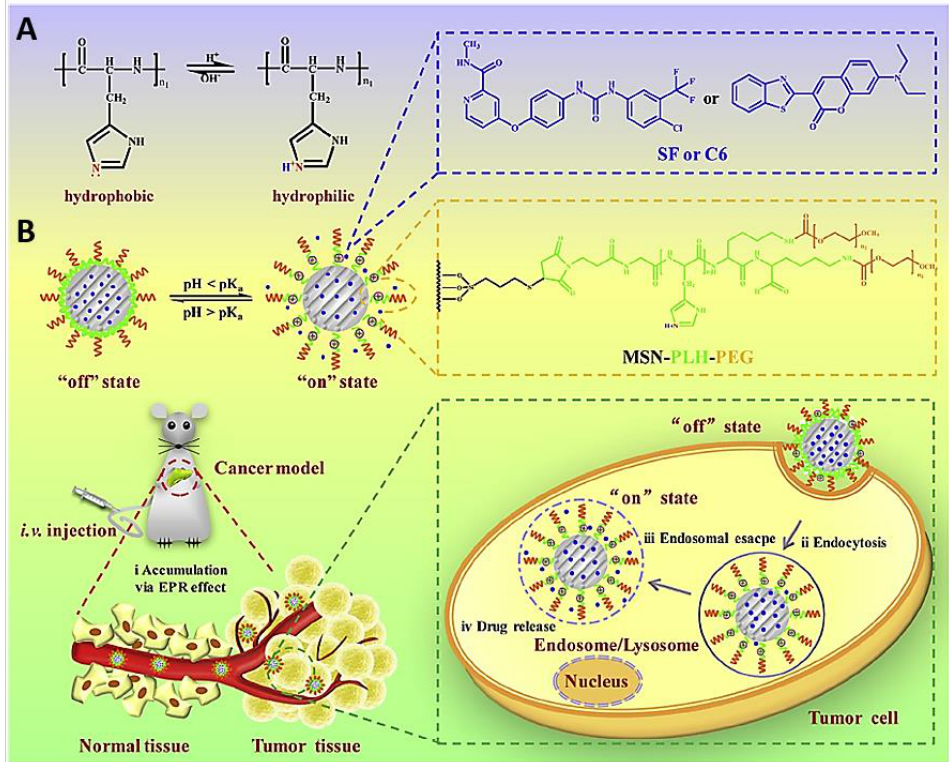
Figure 16. Schematic illustration of: ( A ) The pH-responsive principle of PLH. At neutral pHs, PLH are hydrophobic; whereas at low pH, unsaturated nitrogen in imidazole accepts protons, thereby, PLH displays hydrophilicity. ( B ) Schematic of the pH-controlled drug delivery of SF/MSNs-PLH-PEG bearing an “on-off” switch. (i) Nanoparticles with an “off” switch accumulate in tumor site via EPR effect; (ii) PLH accepts proton and facilitates the endocytosis of nanoparticles by tumor cells; (iii) After being endocytosed by tumor cells, the nanoparticles escape from the endosomes/lysosomes, due to the proton sponge effect of PLH; hence, the PLH coating could be switched “on” gradually; (iv) Drug release from nanoparticles to play its anticancer roles. Adapted from ref. [162]. Copyright 2017, Elsevier